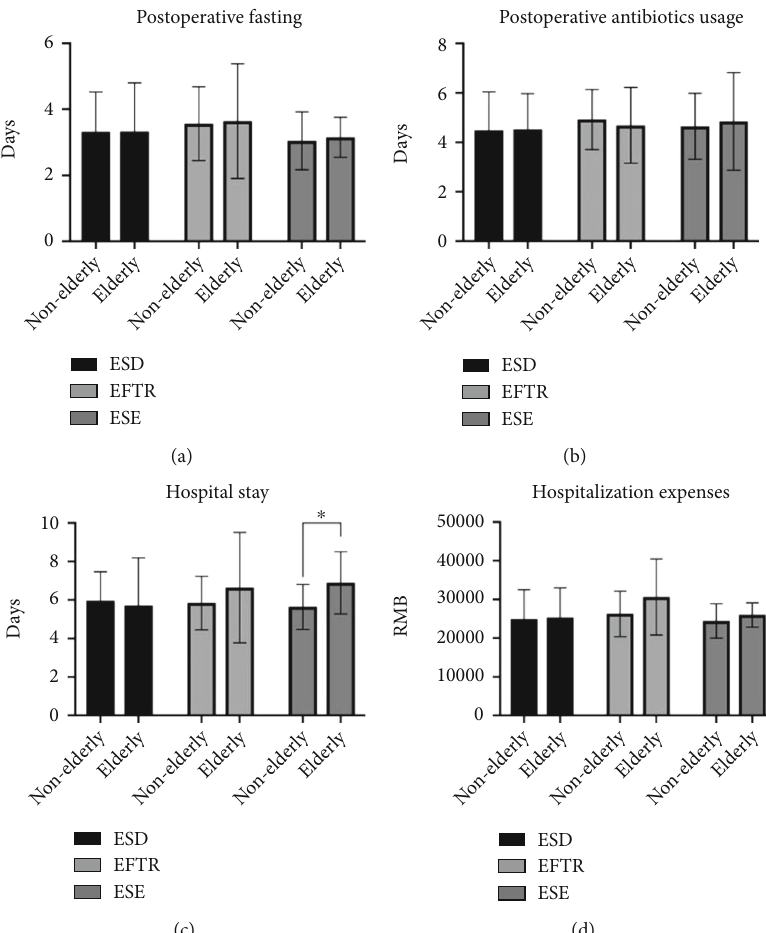
Figure 7: Subgroup analysis on clinical outcomes of elderly and nonelderly patients: (a) postoperative fasting; (b) postoperative antibiotic usage; (c) hospital stay; (d) hospitalization expenses. ESD: endoscopic submucosal dissection; EFTR: endoscopic full-thickness resection; ESE: endoscopic submucosal excavation. ∗ p < 0 : 05